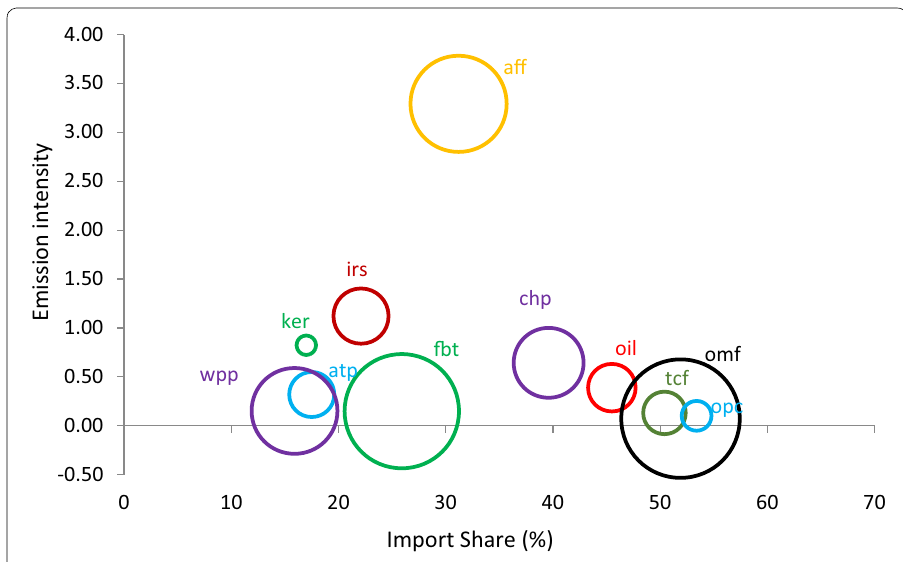
Fig. 4 Emissions intensity and import exposure of sectors. Note Size of bubble represents output. Source Calculated from data obtained from DCCEE, DFAT and